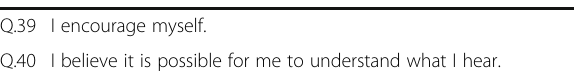
Table 1 General listening strategy questionnaire